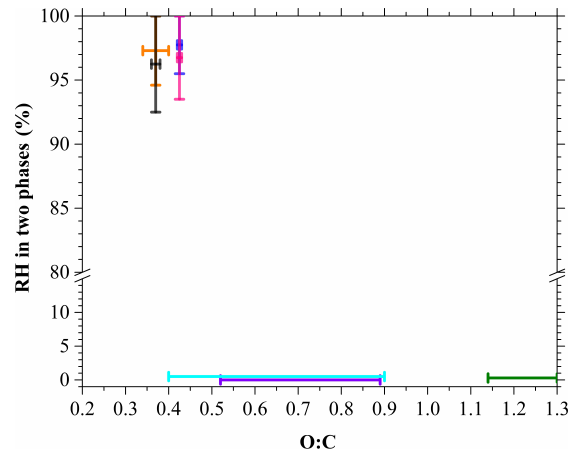
Figure 6. Relative humidity in two phases as a function of the aver- age O : C of SOA particles derived from α -pinene ozonolysis (pink) and α -pinene photooxidation (cyan) in this study, β -caryophyllene ozonolysis (black) from Song et al. (2017), α -pinene ozonolysis (blue) from Renbaum-Wolff et al. (2016), limonene ozonolysis (or- ange) from Song et al. (2017), toluene photooxidation (green) from Song et al. (2017) and isoprene photooxidation (purple) from Ras- tak et al. (2017). The O : C and related experimental conditions are summarized in Tables S1 and S2 in the